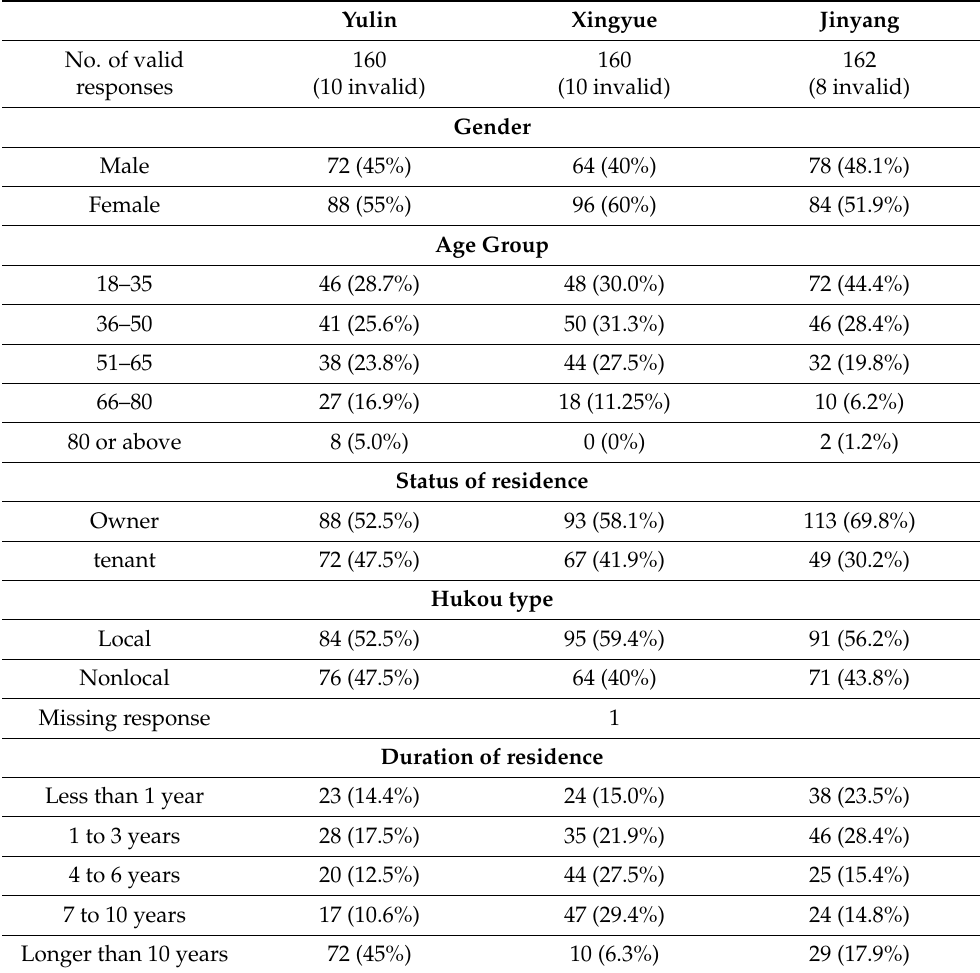
Table 2. Socioeconomic profiles of the three